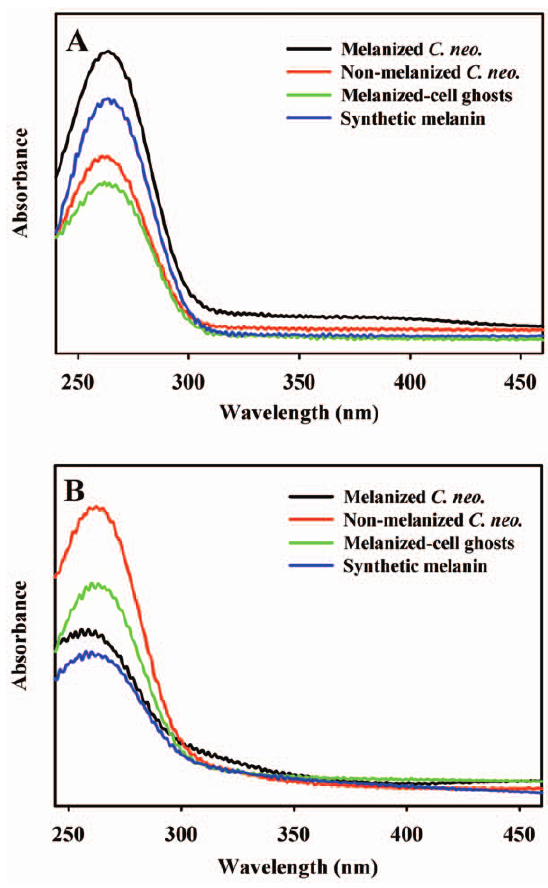
Figure 5. Optical spectra of supernatants collected from c - irradiated or Fenton reagent-treated samples. A) melanized C. neoformans cells, non-melanized C. neoformans cells, melanized-cell ghosts, and synthetic melanin, irradiated for 30 min at room temperature in PBS; B) as in A, incubated with Fe(II) and H 2 O 2 (Fenton reagent).